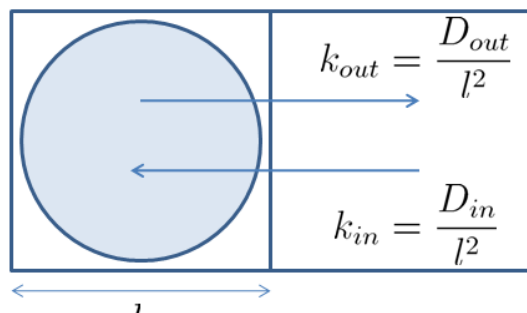
Figure 13: The diffusion event from box to box of the grid representing the physical space is modelled as a first order reaction whose rate constants is proportional to the diffusion coefficient. In our model the diffusion coefficient is space-dependent, so that it has different values in different boxes depending on the local values of bicoid concentration, frictional coefficient and chemical